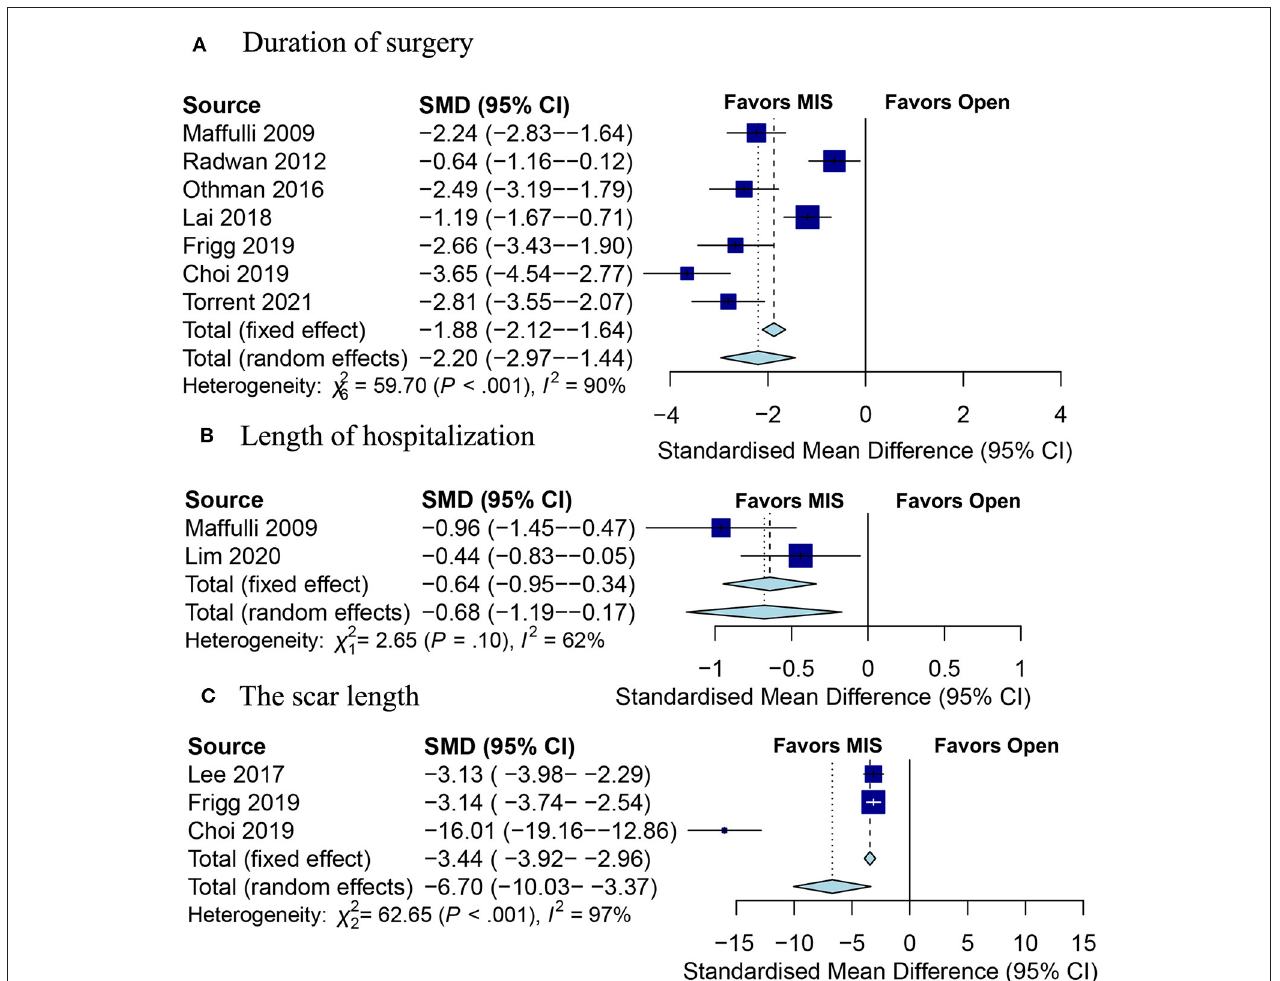
FIGURE 5 | Forests plot of secondary outcomes between the MIS and open groups. (A) Duration of surgery; (B) length of hospitalization; (C) the scar length. MIS, minimally invasive